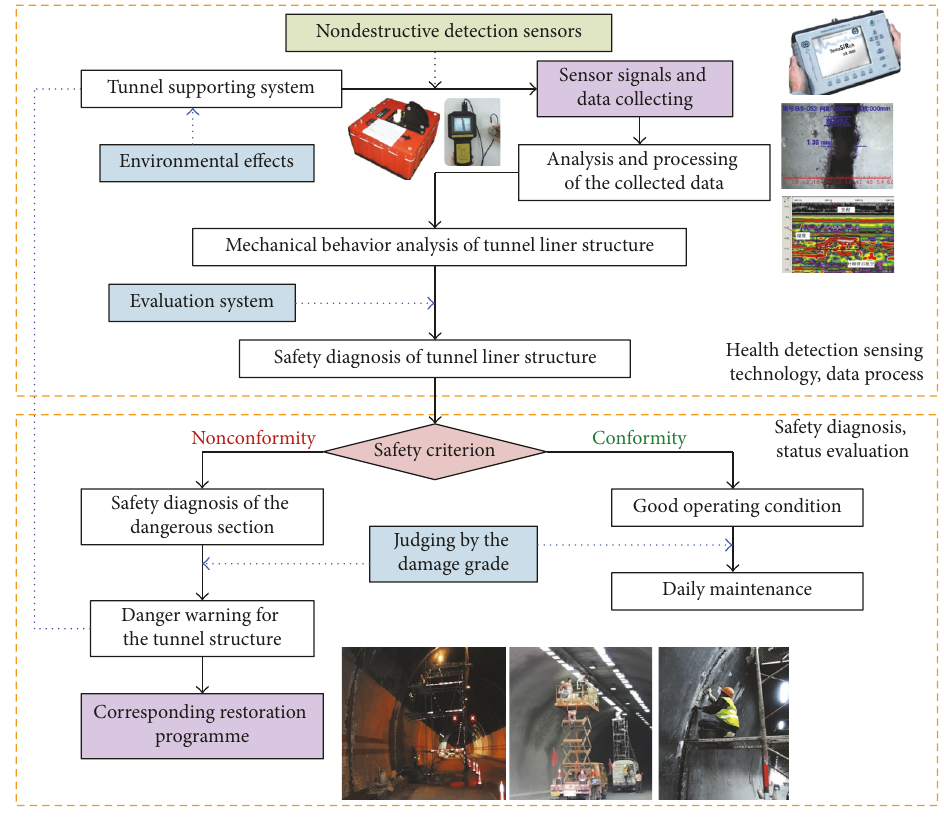
Figure 2: Safety assessment system of the tunnel structure.